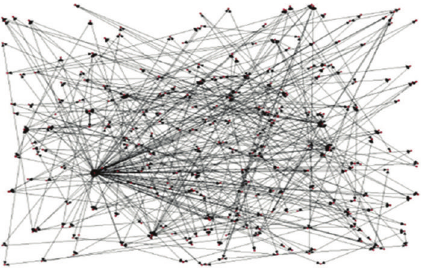
Figure 4: The shortest spread paths of information